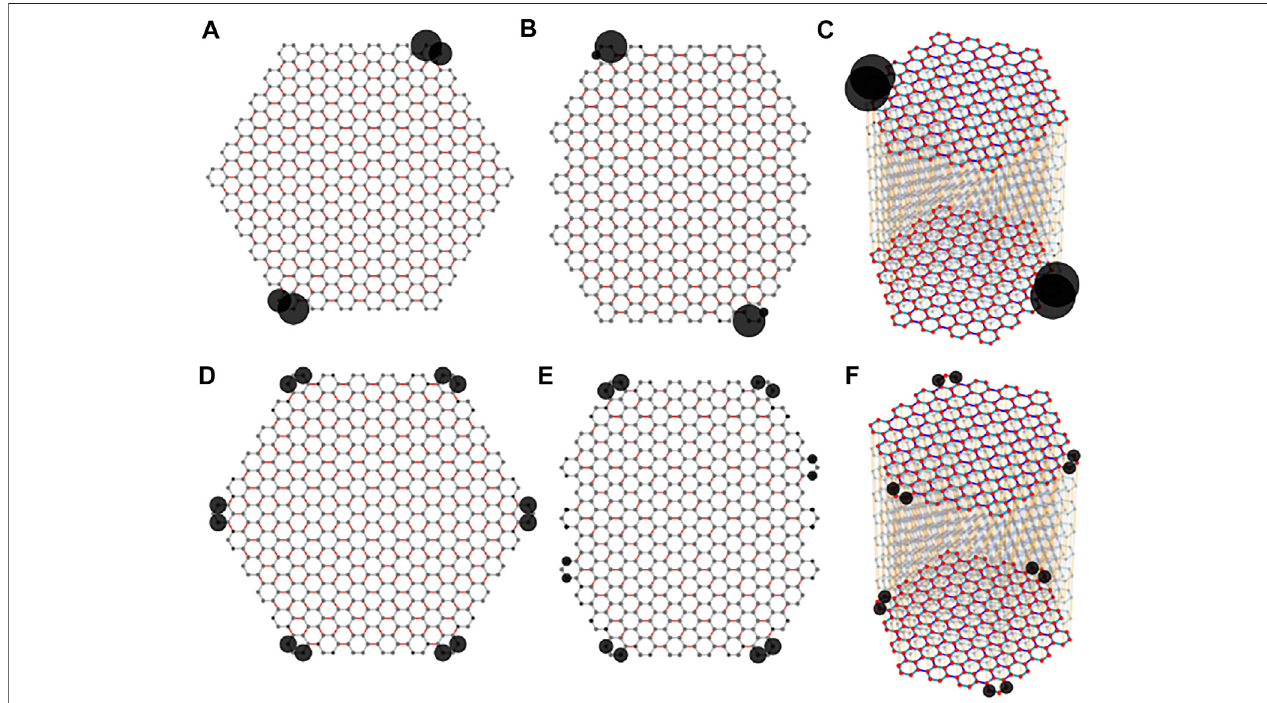
FIGURE5|(A,D) Orthohexagonalsamplewithoneandthreepairsofzero-modecornersrespectively.Theparametersaresetas t 1 (cid:2) 1 . 3 , t 2 (cid:2) 1 . 5 , t 3 (cid:2) 0 . 5 , t 1 , 2 , 3 ′ (cid:2) 3 for (A) and t 1 , 2 , 3 (cid:2) 1 , t 1 , 2 , 3 ′ (cid:2) 3 for (D) . (B,E) Octagonal sample with one and three pairs of zero-mode corners respectively. The parameters are set as t 1 , 2 (cid:2) 1 , t 3 (cid:2) 0 . 3 , t 1 , 3 ′ (cid:2) 3 , t 2 ′ (cid:2) 2. for (B) and t 1 , 2 , 3 (cid:2) 1 , t 1 , 3 ′ (cid:2) 3 , t 2 ′ (cid:2) 2 for (E) . (C,F) Hexagonal prisms sample with one and three pairs of corner zero-modes respectively. The parameters can be seen in Supplementary Appendix SAC